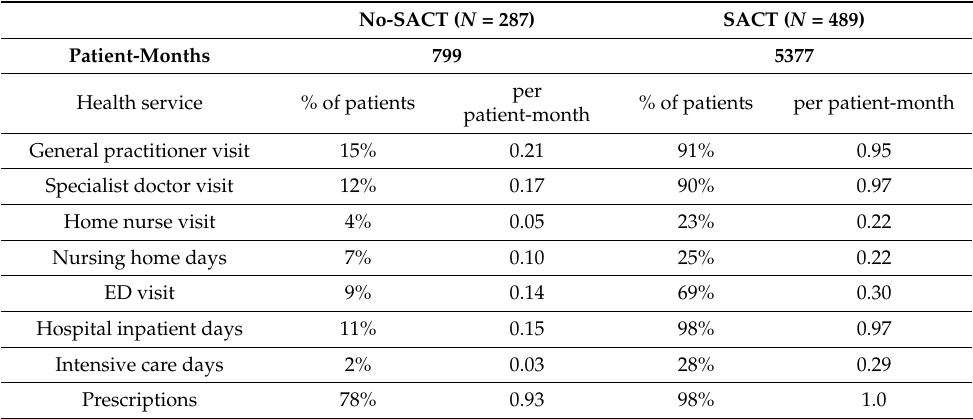
Table 2. Proportion of patients and frequency of use of different health care services during the observation period until death or data